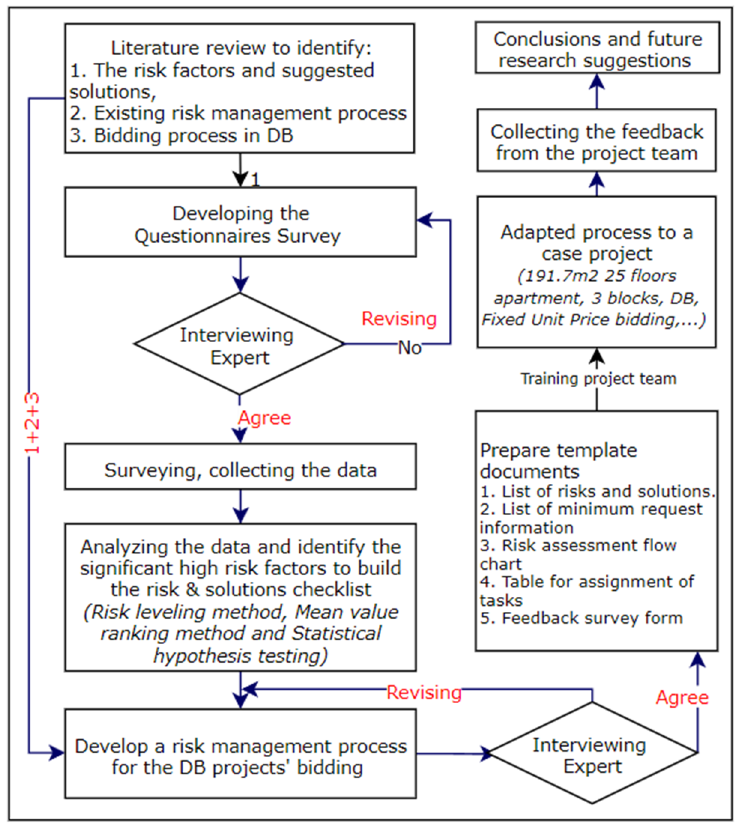
Figure 1. Workflow of the research.